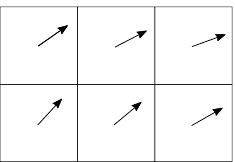
Figure 8: A global pointing correction is estimated for the whole processed region of interest from the local corrections that were computed in each tile. In this example, the region was cut into 6 tiles. In each tile a corrective translation was computed and is represented by an arrow starting from the center of the tile. The 6 corrective translations are used to estimate an affine transforma- tion that corrects the relative pointing error on the whole region.